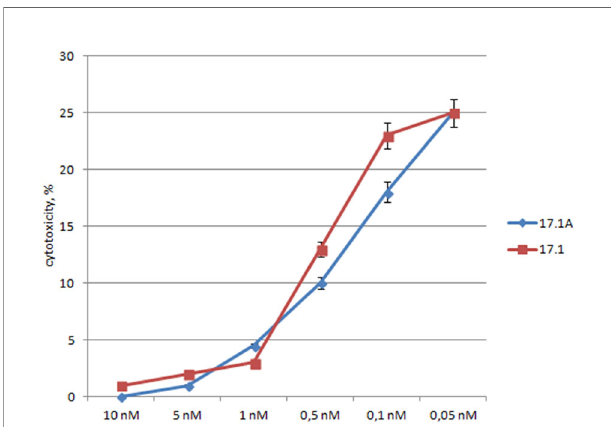
FIGURE 3 | The relationship between the cytotoxic activity and the concentrations of inhibitory peptides. Inhibitory 17.1 and 17.1A peptides in preset concentrations were added 1h prior to incubation with TNF a (10 -10 M). The cytotoxic activity was measured 24 h after cell incubation with a cytotoxic agent. All data are presented as mean ± SEM for at least three independent